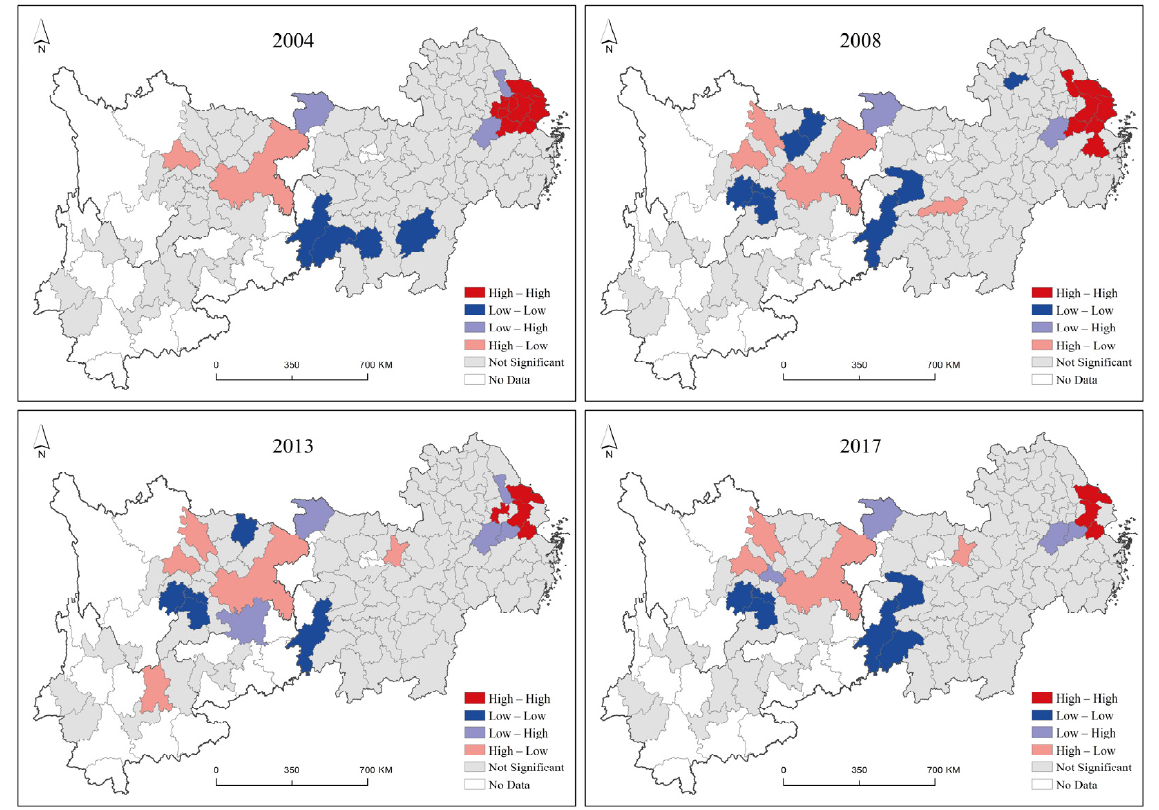
Figure 5. Local spatial autocorrelation clustering map of green development level.